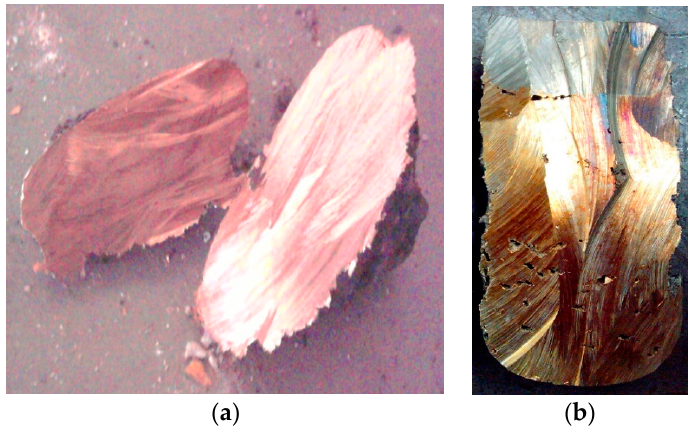
Figure 7. Photographs present surfaces of cut-through metal samples. Left picture ( a ) presents metal ingot from experiment no. 1. Right picture ( b ) presents remelted metal sample from experiment no. 3—visible segregation of metals into two layers, top (iron-rich) and bottom (copper-rich).